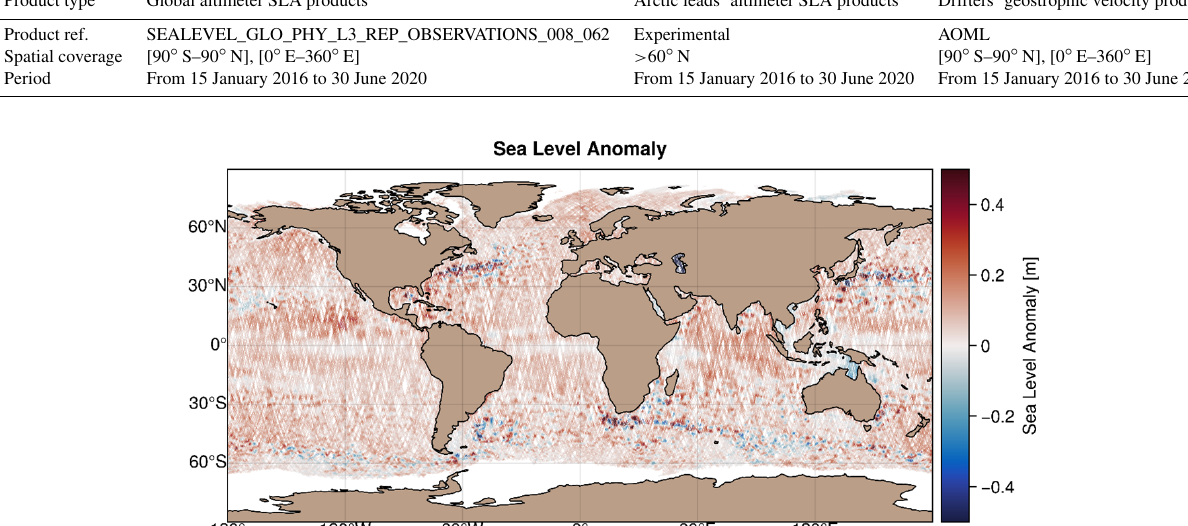
Figure 1. Example of sea-level altimetry coverage for a 7d period (from 1 July 2019 to 7 July 2019). Colour scale represents the sea-level anomaly amplitude in metres. For this time interval, data originate from six altimeters: Jason-3, Sentinel-3A, Sentinel-3B, SARAL/AltiKa, Cryosat-2, and